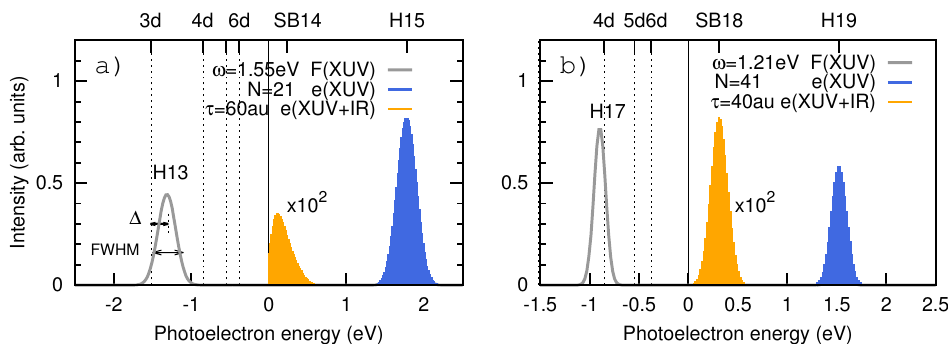
Figure 2. ( a ) Photoelectron spectrum of Ne at ω = 1.55 eV (800 nm) is overlapped with the spectrum of the driving XUV pulse. The primary harmonic peak H15 and the scaled sideband SB14 are shaded in blue and orange, respectively. The submerged harmonic peak H13 overlaps with the dicrete 3 d energy level. The arrows indicate the detuning ∆ and FWHM; ( b ) same for ω = 1.21 eV (1024 nm) where the submerged harmonic peak H17 overlaps with the 4 d bound state and SB18 emerges above the